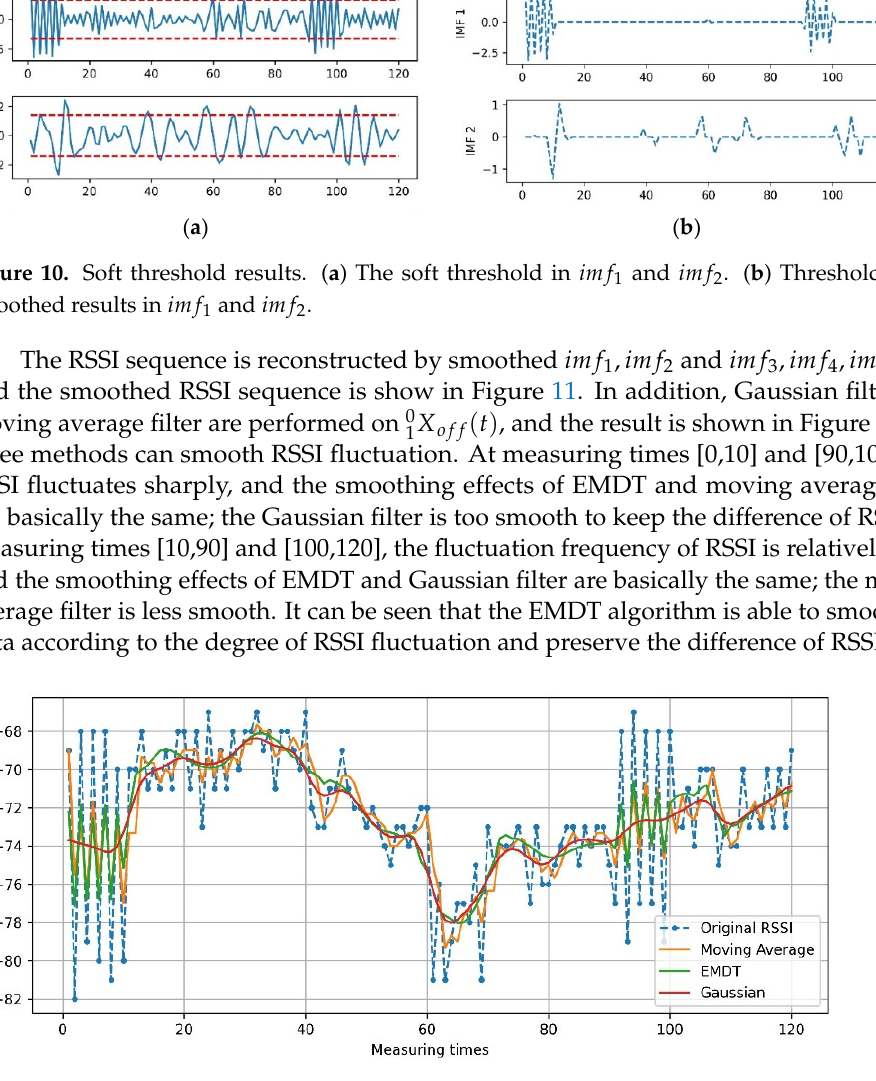
Figure 11. RSSI value smoothed by EMDT.